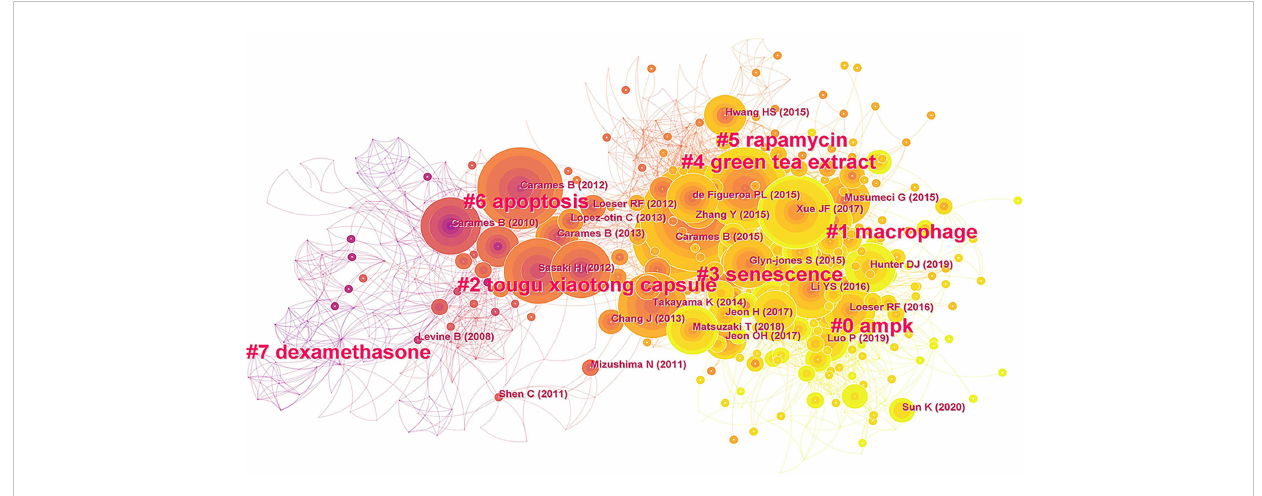
FIGURE 7 CiteSpace visualization map of co-cited references in OA